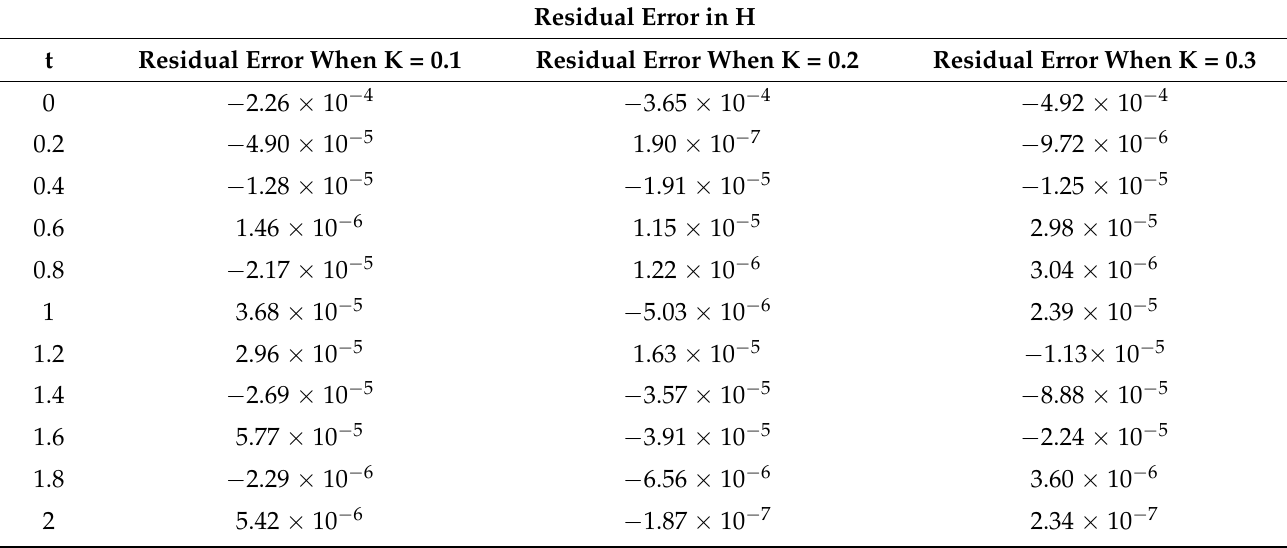
Table 8. Residual error in H between the Mathematica and neural